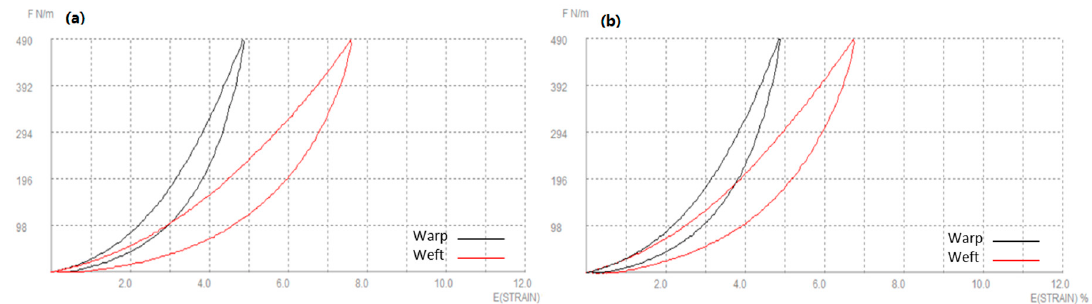
Figure 9. Tensile property of ( a ) woollen fabric; ( b ) woollen fabric with interlining.